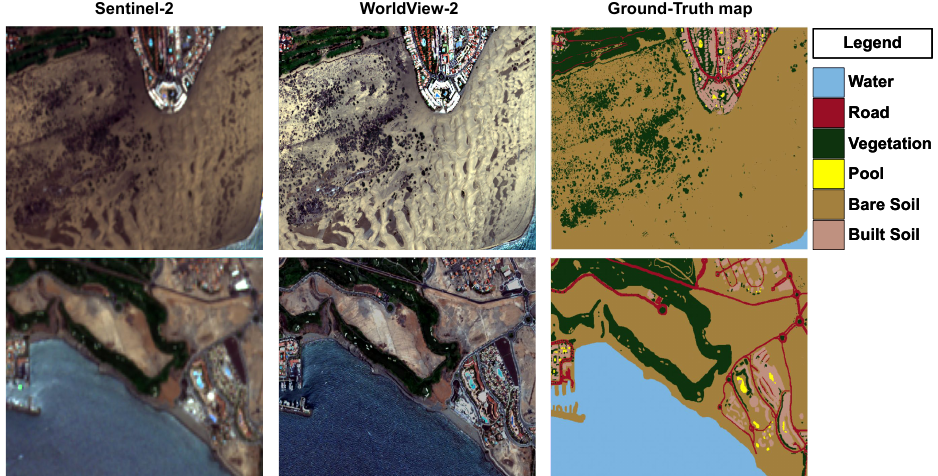
Figure 3. Examples of the dataset after the manual relabeling